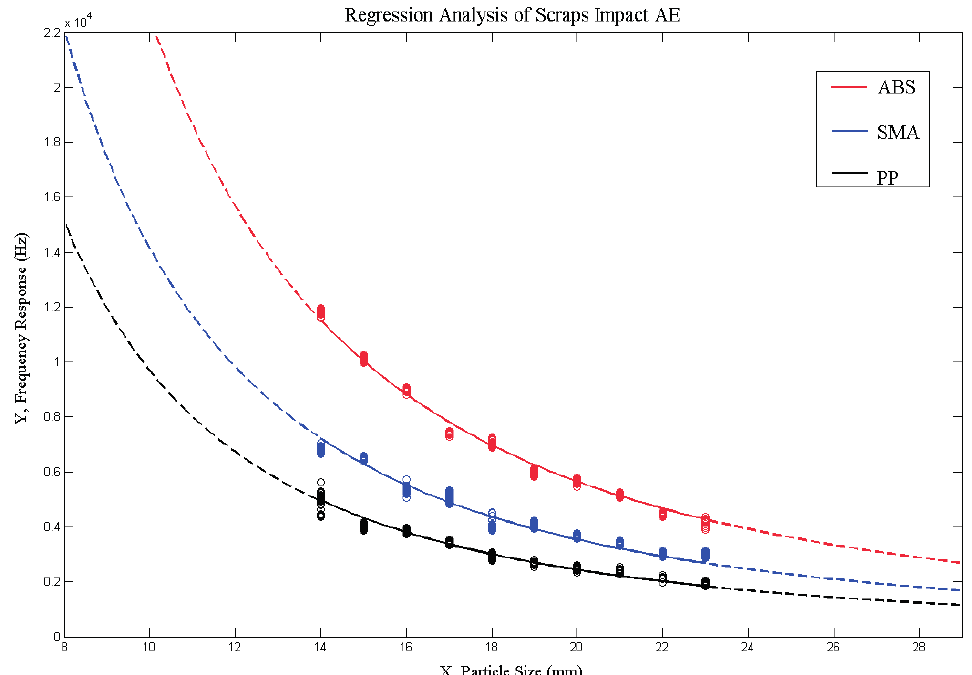
Figure 6. Fitting results of all three kinds of